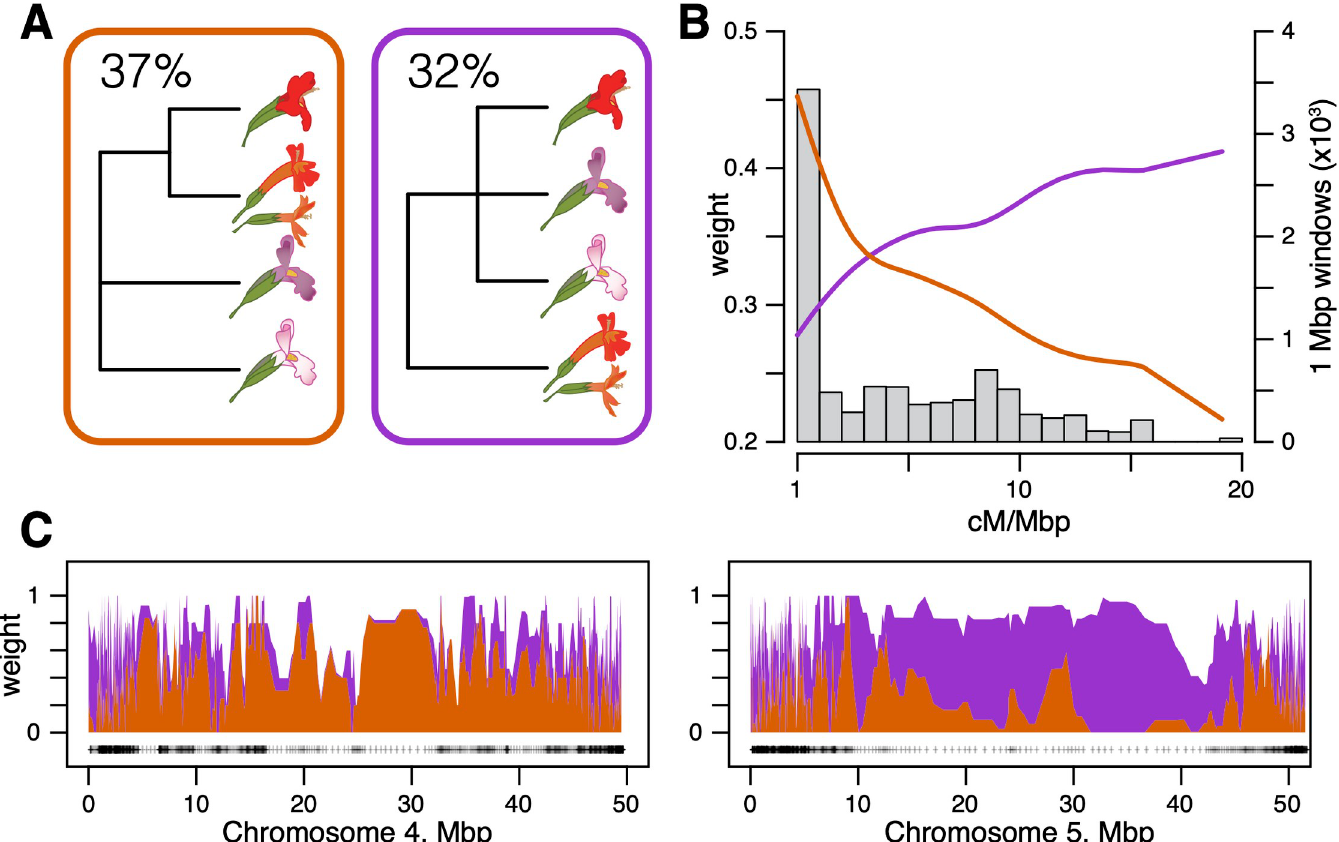
Fig 3. Introgression has generated the evidence for sisterhood of M . lewisii and M . cardinalis . (A) Genome-wide TWISST weightings for a simplified species tree (orange) and a simplified “lew-card” tree (purple). (B) Support for the species and lew-card trees as a function of recombination rate. Lines show cubic spline fits colored as in A. The gray histogram shows the frequency of genomic windows at a given recombination rate (bin size: 1 cM/Mbp). (C) Topology weights along M . cardinalis Chromosomes 4 and 5. Polygons are stacked so that weights across all possible topologies (including those not shown) sum to 1. Weights are averaged in windows of 5 genes; black crosses show locations of window midpoints. See S7–S14 Figs for topology weights across all 8 M . cardinalis chromosomes.